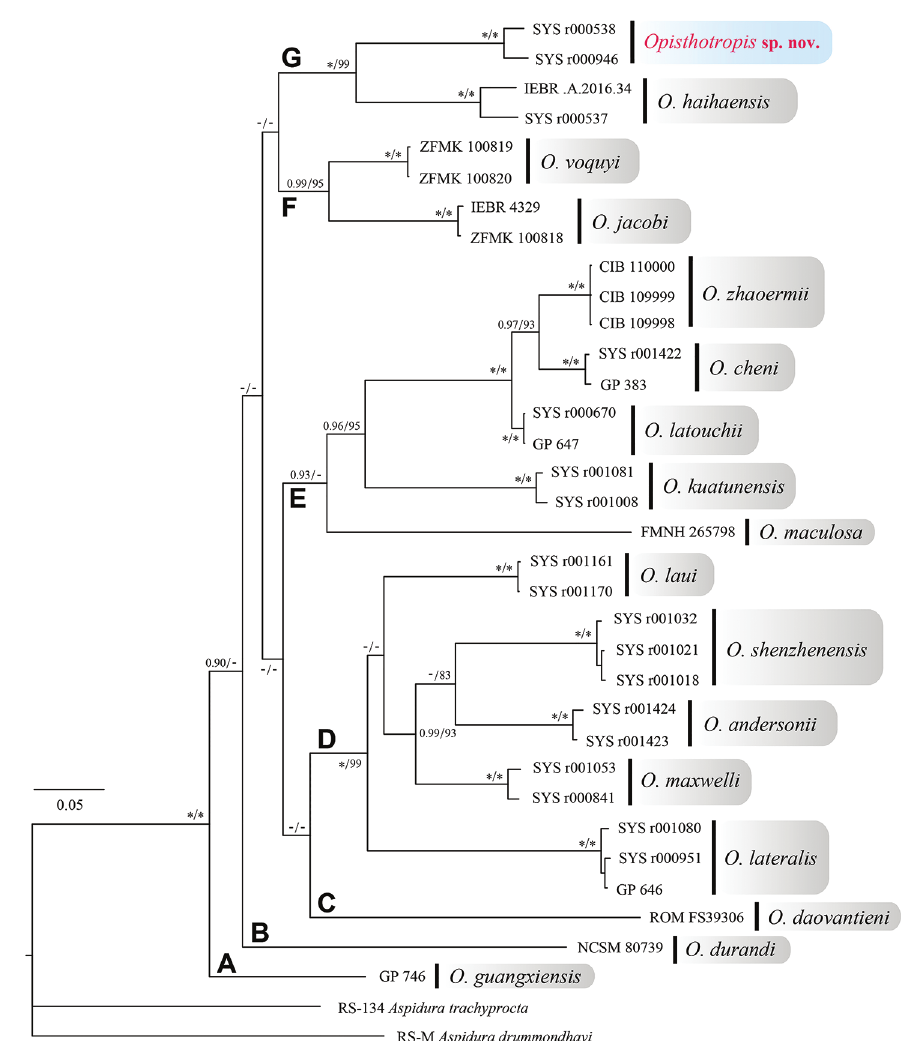
Figure 2. Bayesian Inference and Maximum Likelihood phylogenies. The Bayesian posterior probabili- ties (BPP) > 0.90 and the bootstrap supports for Maximum Likelihood analysis (BS) > 80 were